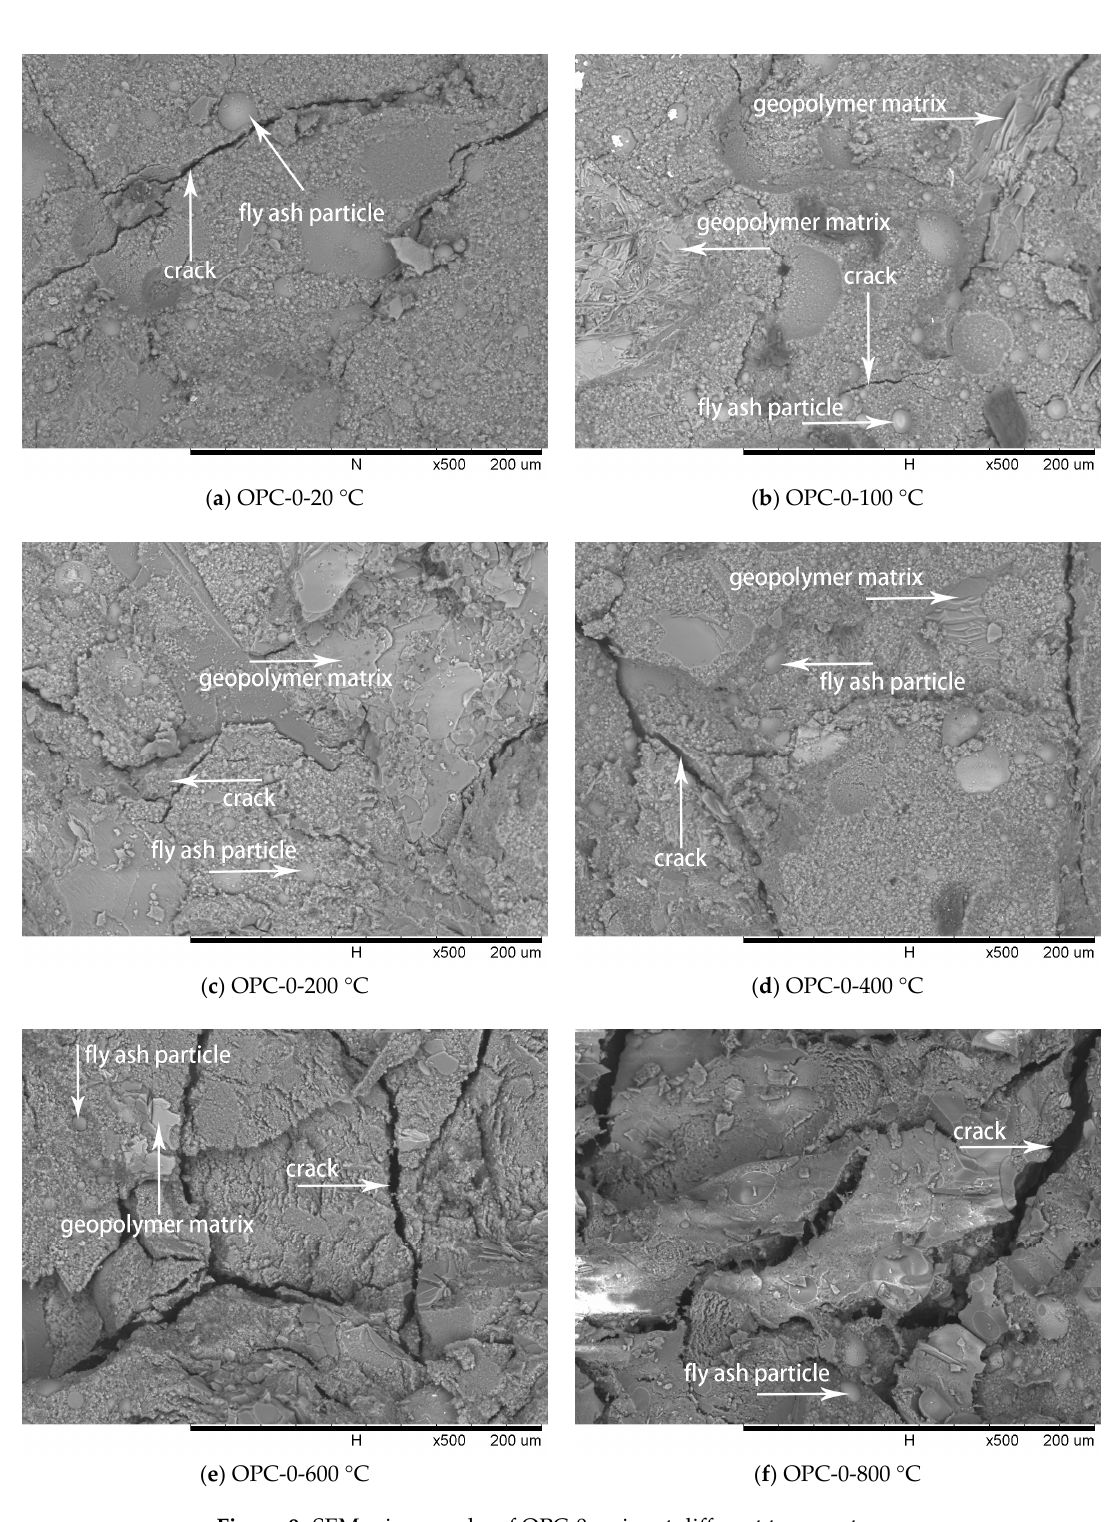
Figure 9. SEM micrographs of OPC-0 series at different temperatures.